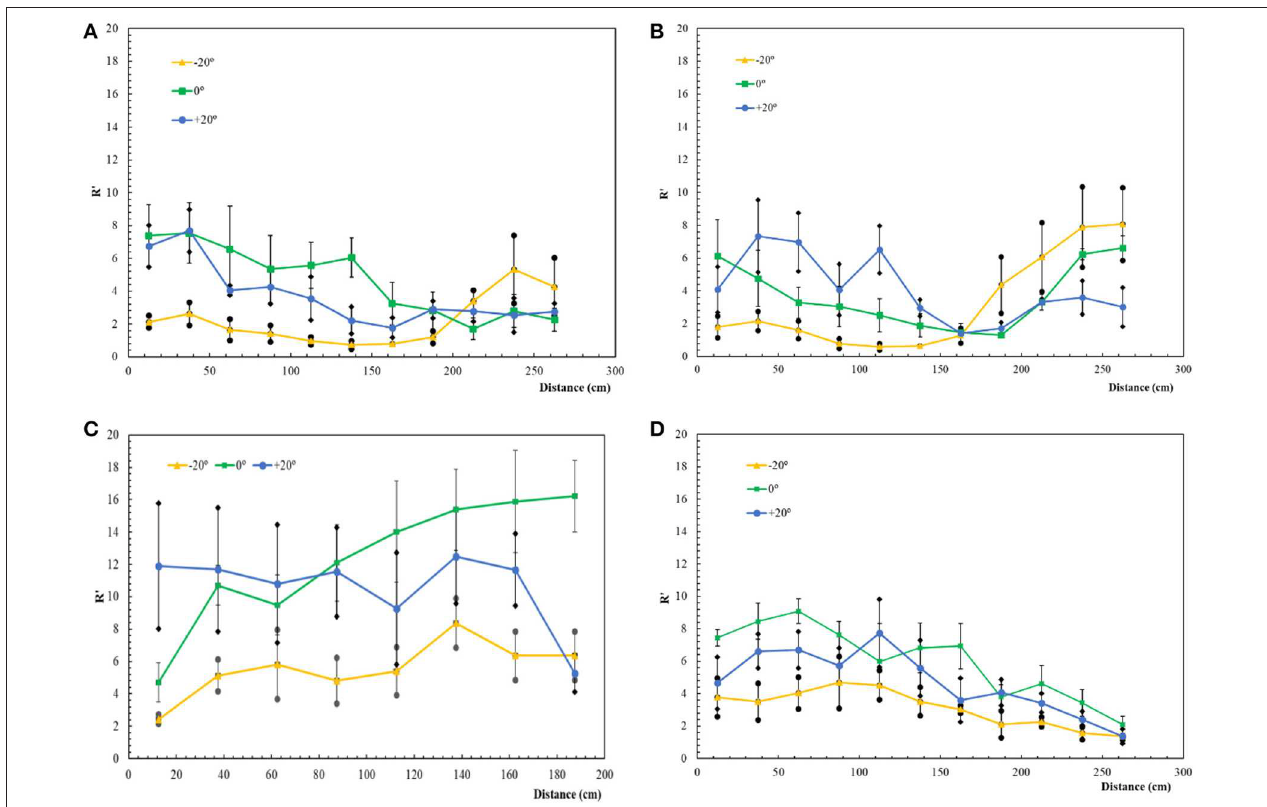
FIGURE 7 | Mean value of R’ for tests with α = 30 ◦ and β = 0 ◦ – (A) Line a; (B) Line b; (C) Line c; (D) Line d. The error bars correspond to a level of confidence of